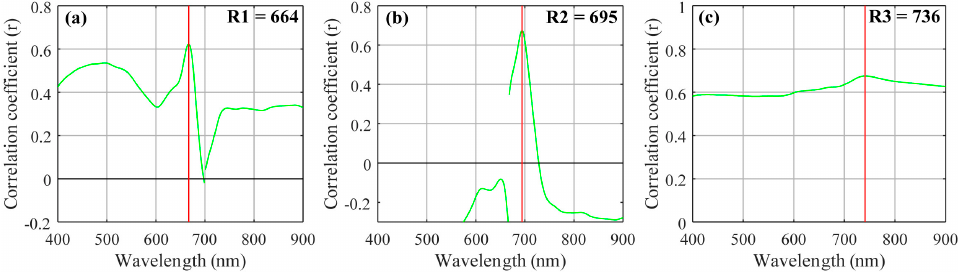
Figure 2. Correlation between observed and modelled chlorophyll a (Chl- a ) using ocean chlorophyll (OC) algorithms. The first row shows results using standard coefficients ( a ) OC2; ( b ) OC3; and ( c ) OC4. The second row shows results from recalibrated OC models using the dataset of this study ( d ) OC2; ( e ) OC3; and ( f ) (OC4).